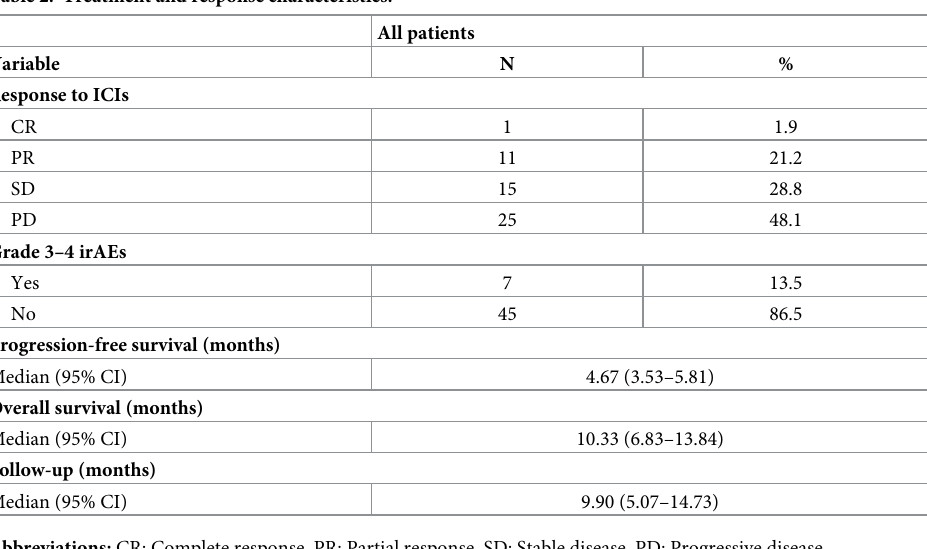
Table 2. Treatment and response